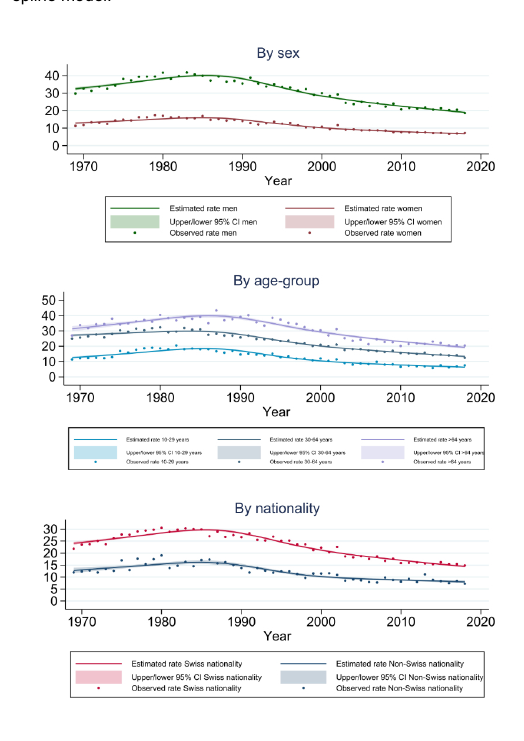
Figure 1: Suicide rates per 100,000 population (person-years). Note: estimated true rates and associated confidence intervals (CI) were derived from Poisson regressions using a restricted cubic- spline model.